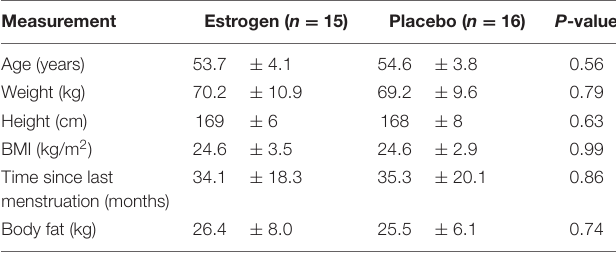
TABLE 1 | Subject characteristics at